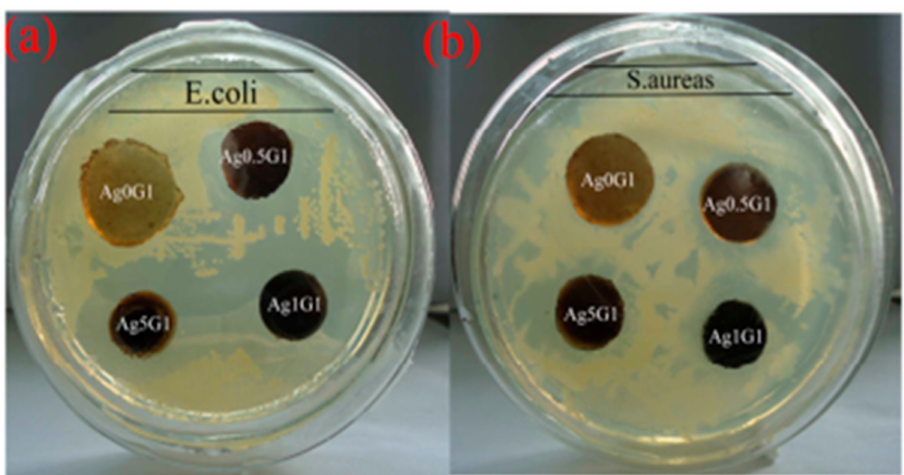
Figure 1. Photographs showing the antibacterial activity of PNIPAM-based hydrogels with different Ag:G weight ratios (0.5:1, 1:1 and 5:1) are denoted as Ag0.5G1, Ag1G1 and Ag5G1, respectively, against E. coli ( a ) and S. aureus ( b ). Reprinted with permission from ref. [41]. Copyright 2021 Advanced Functional